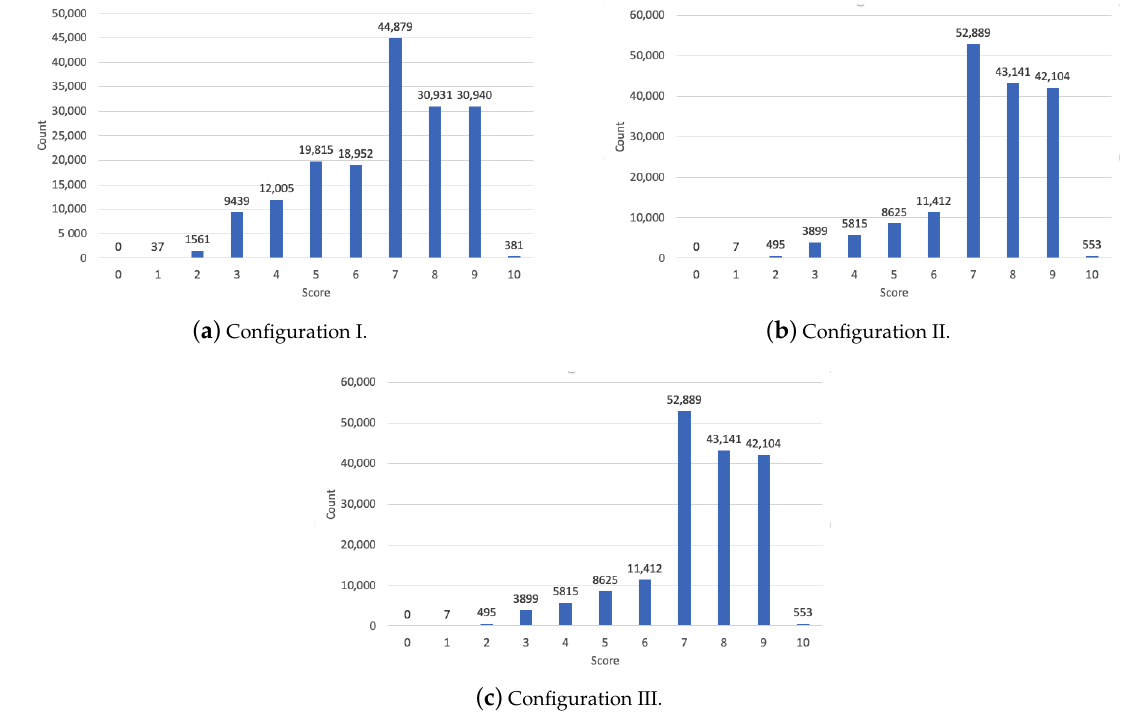
Figure 4. CVSS Environmental 3.1